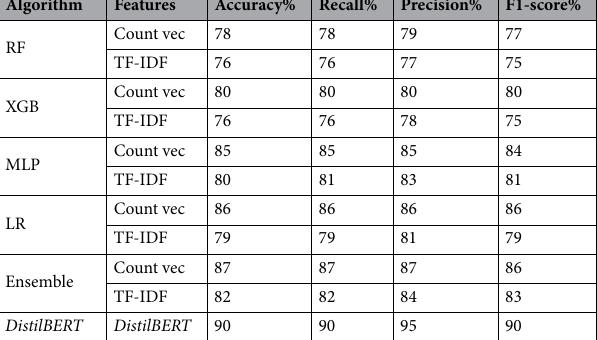
Table 5. All Feature Extraction and algorithm Results for Article2 Dataset with 20 Authors.